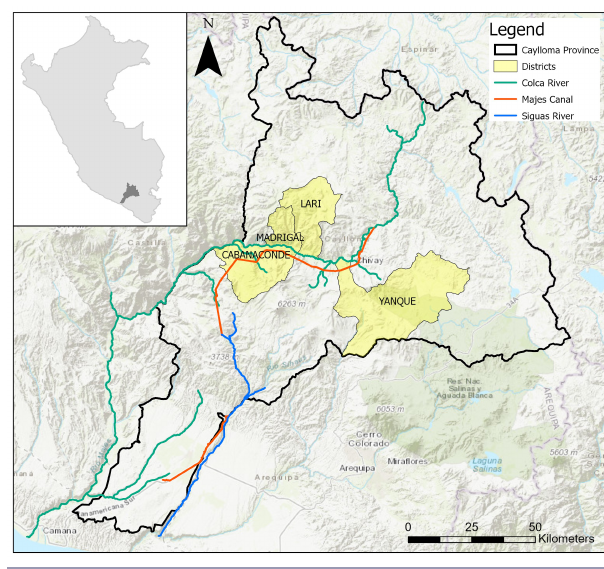
Fig. 1 . Study districts in the Caylloma Province, Peru. Sources: Esri, HERE, Garmin, Intermap, increment P Corp., GEBCO, USGS, FAO, NPS, NRCAN, GeoBase, IGN, Kadaster NL, Ordnance Survey, Esri Japan, METI, Esri China (Hong